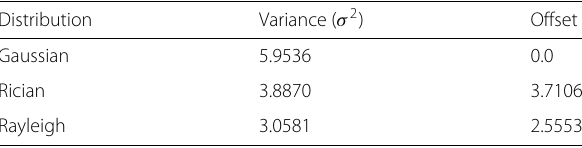
Table 2 Sample parameters used in the multi-watermark MATLAB/Simulink